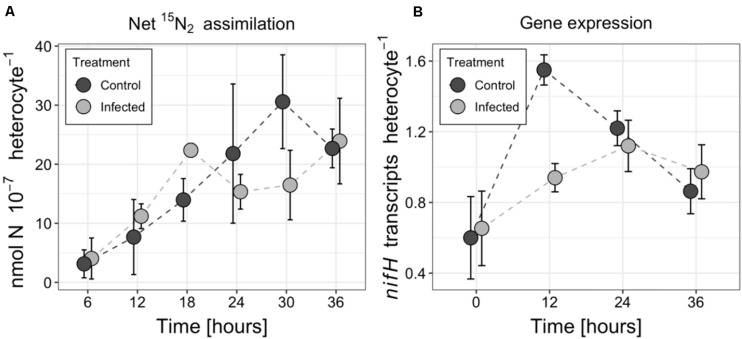
Changes in nitrogen fixation (A) and nifH transcript abundance (B) in the control and infected cultures of the Aphanizomenon flos-aquae strain 2012/KM1/D3. Symbols indicate the mean values, and the error bar shows the standard deviation of three technical replicates.